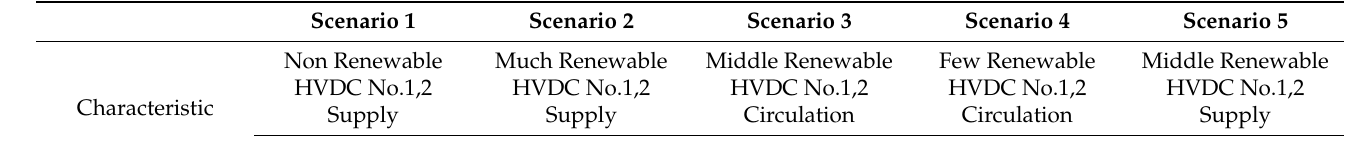
Table 9. Scenario B configuration (HVDC#3 transmission).